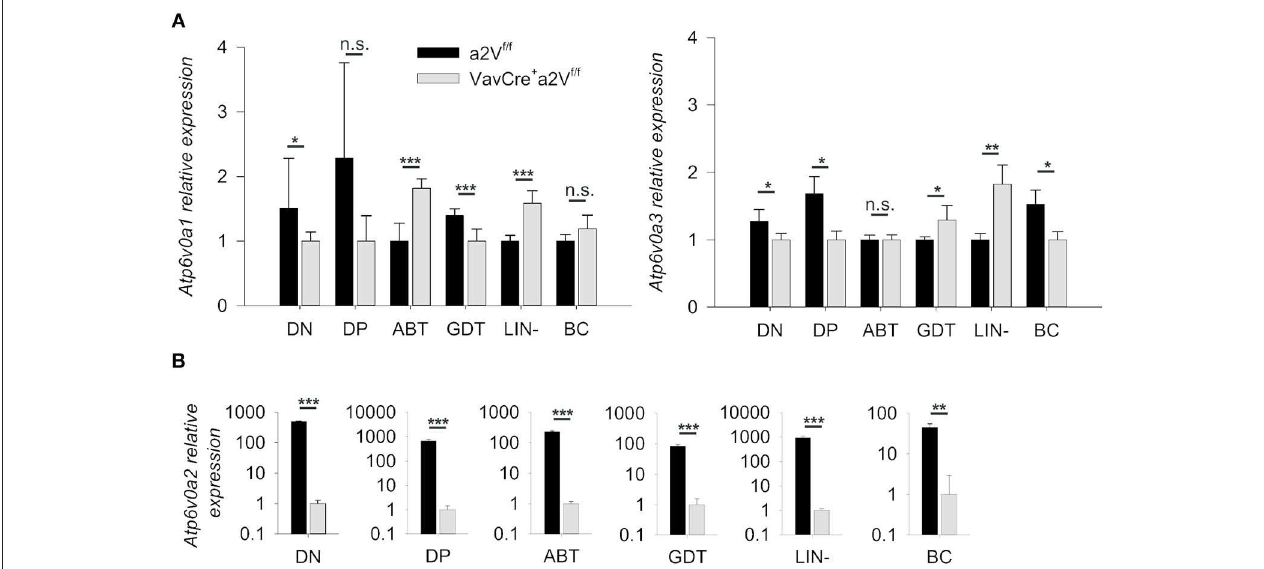
FIGURE 1 | Quantification of V-ATPase isoform mRNA expression. (A) Atp6v0a1 (a1V) and Atp6v0a3 (a3V) isoform expression levels relative to GAPDH in sorted leukocyte populations from a2V fl / fl and Vav Cre a2V fl / fl thymuses (DN and DP) or spleens (ABT, GDT, Lin-, and BC). (B) Atp6v0a2 (a2V) isoform expression relative to GAPDH and β -Actin in sorted populations of splenocytes and thymocytes. Atp6v0a4 (a4V) expression was not detectable in any populations. ABT, αβ T cells (CD3 + TCR β + ); BC, B cells (CD19 + ); DN, double negative thymocytes (CD3 − CD4 − CD8 − ); DP, double positive thymocytes (CD3 + CD4 + CD8 + ); GDT, γδ T cells